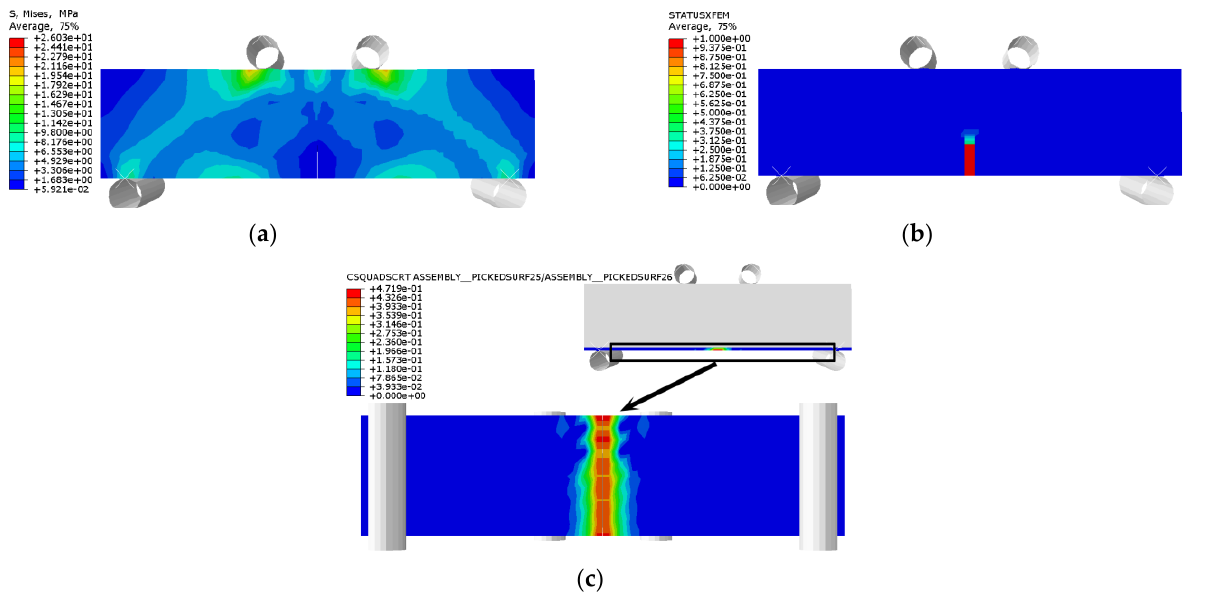
Figure 41. RFND: ( a ) stress nephogram; ( b ) damage nephogram of prefabricated crack; and ( c ) damage nephogram of bonding